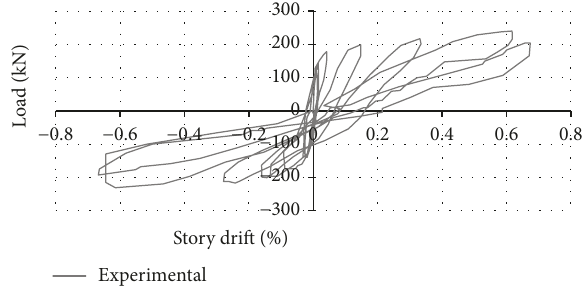
Figure 13: Hysteresis loop of CBM